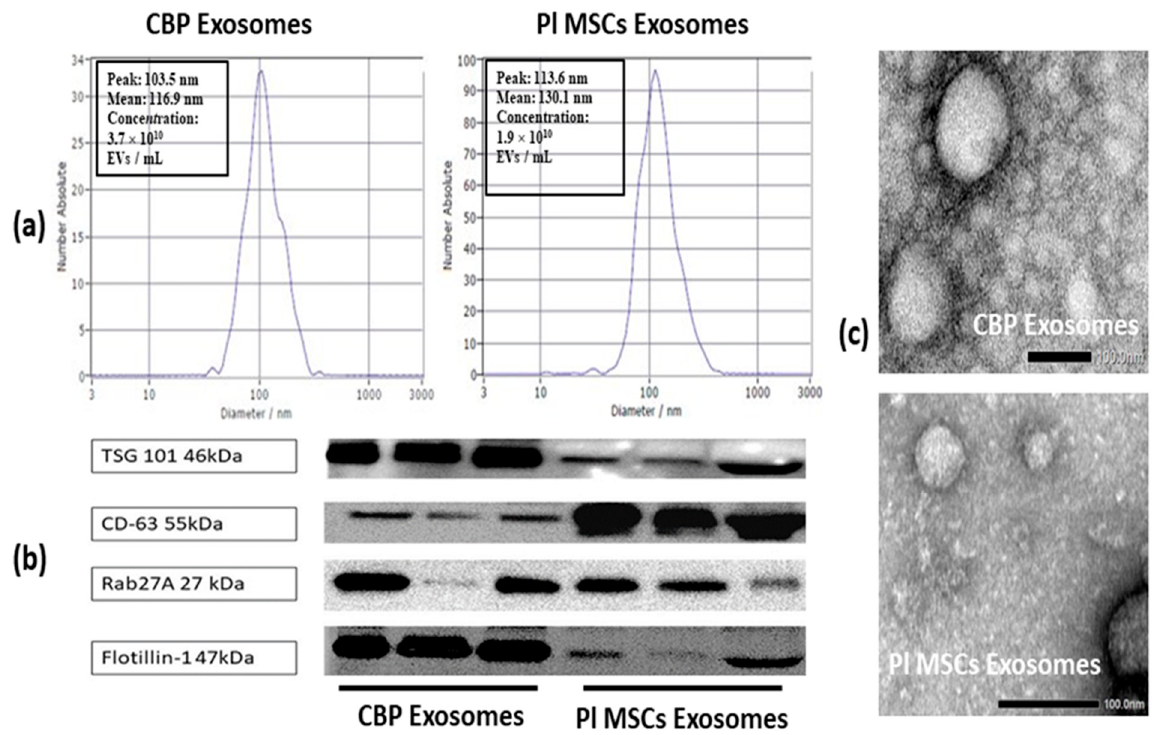
Figure 2. Characterization of exosomes derived from CBP and PL MSCs culture supernatant in our study. ( a ) Nanoparticles Tracking Analysis (NTA) was used to analyze the size and concentration of isolated exosomes. ( b ) Western blot analysis showing the presence of four common exosomes surface markers (CD63, TSG101, Rab27a, and Flotillin1) in both CBP and PL MSCs exosomes. ( c ) Typical morphology of CBP and PL MSCs exosomes observed under a transmission electron microscope (TEM). Scale bar = 0.2 µ m. CBP: Cord blood plasma; PL MSCs: Placenta mesenchymal stem cells. The presence of exosomes is confirmed by the detection of at least four positive protein markers of EVs, including one transmembrane marker (CD63), lipid-bound protein (Flotillin-1), one cytosolic protein (TSG 101) [54], and a small cytosolic protein GTPase marker playing a key role in controlling intracellular transport and secretion of exosomes (Rab 27a)